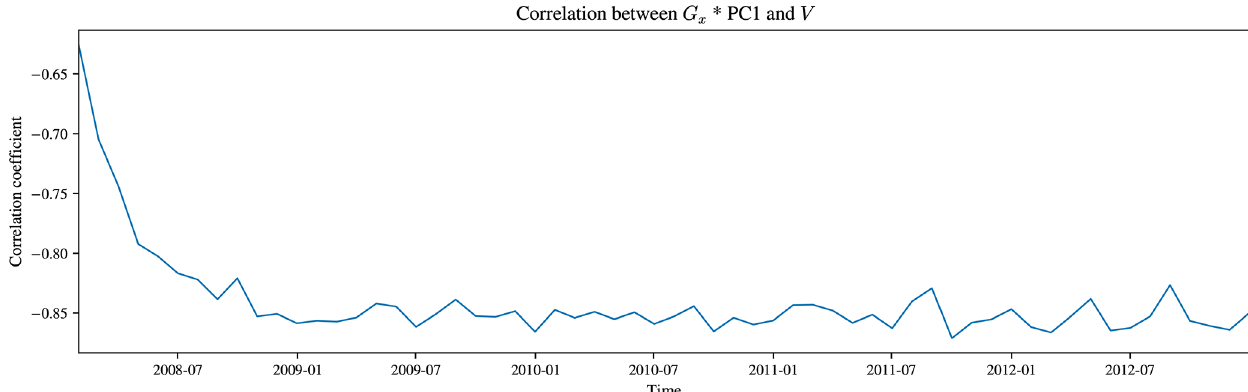
Figure A4. The correlation between the G y ∗ PC1 and the meridional velocity, V , at 2m for each monthly mean in the B-SOSE iteration 106 dataset. The increase in the correlation coefficient over the first 2 years could be interpreted as the spin-up, as in Fig.